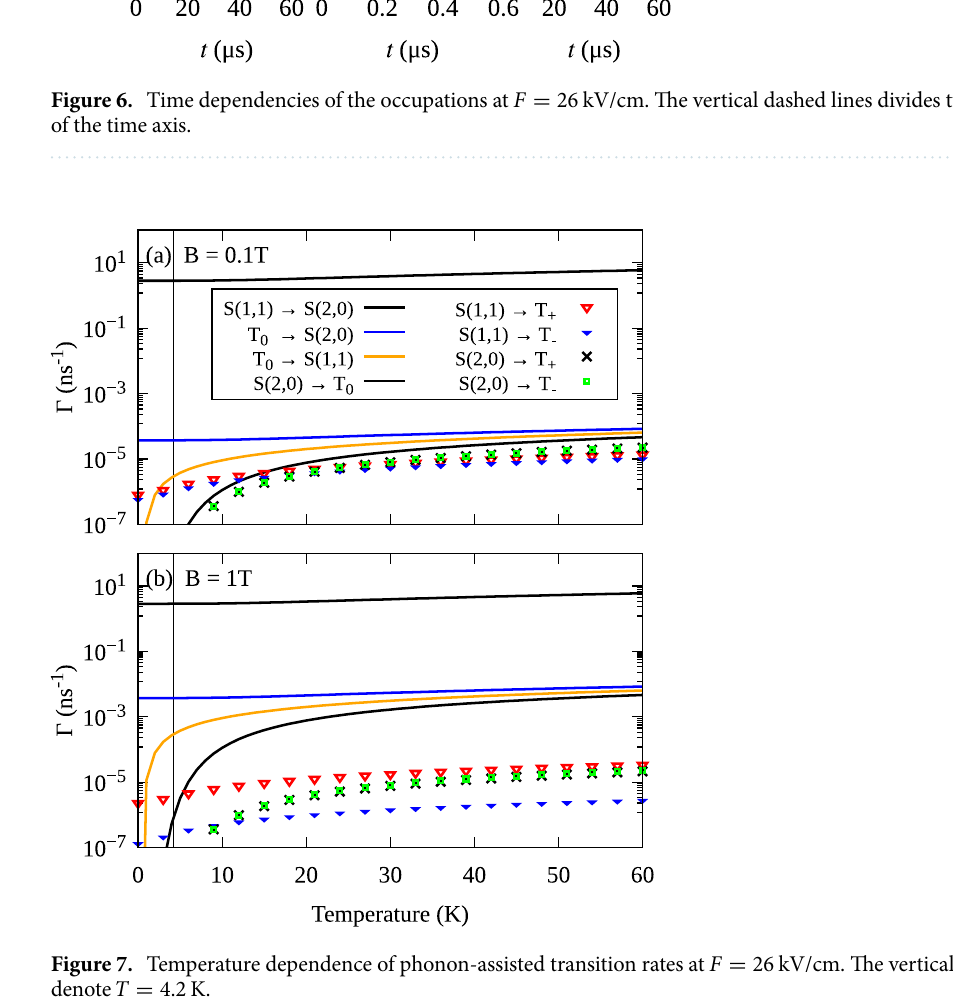
Figure 7. Temperature dependence of phonon-assisted transition rates at F 4.2 denote T =